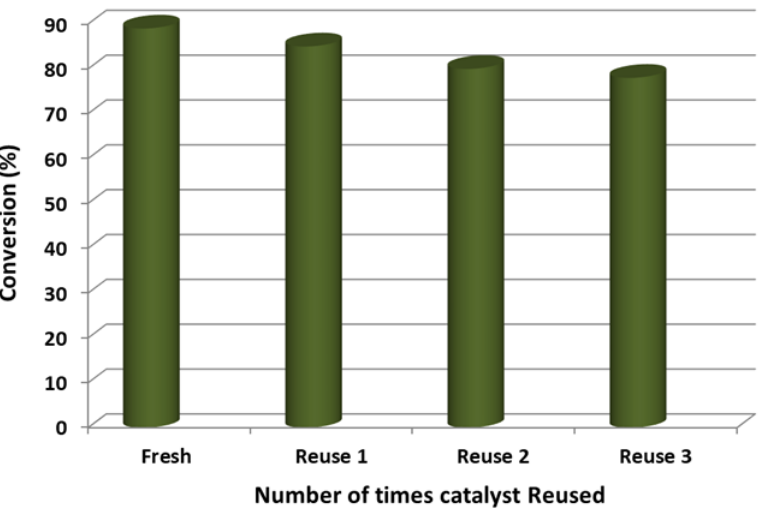
Figure 10. Recyclability studies for the Pd/C 3% catalyst, using p -bromoanisol as the main reactant for the Mizoroki–Heck reaction.